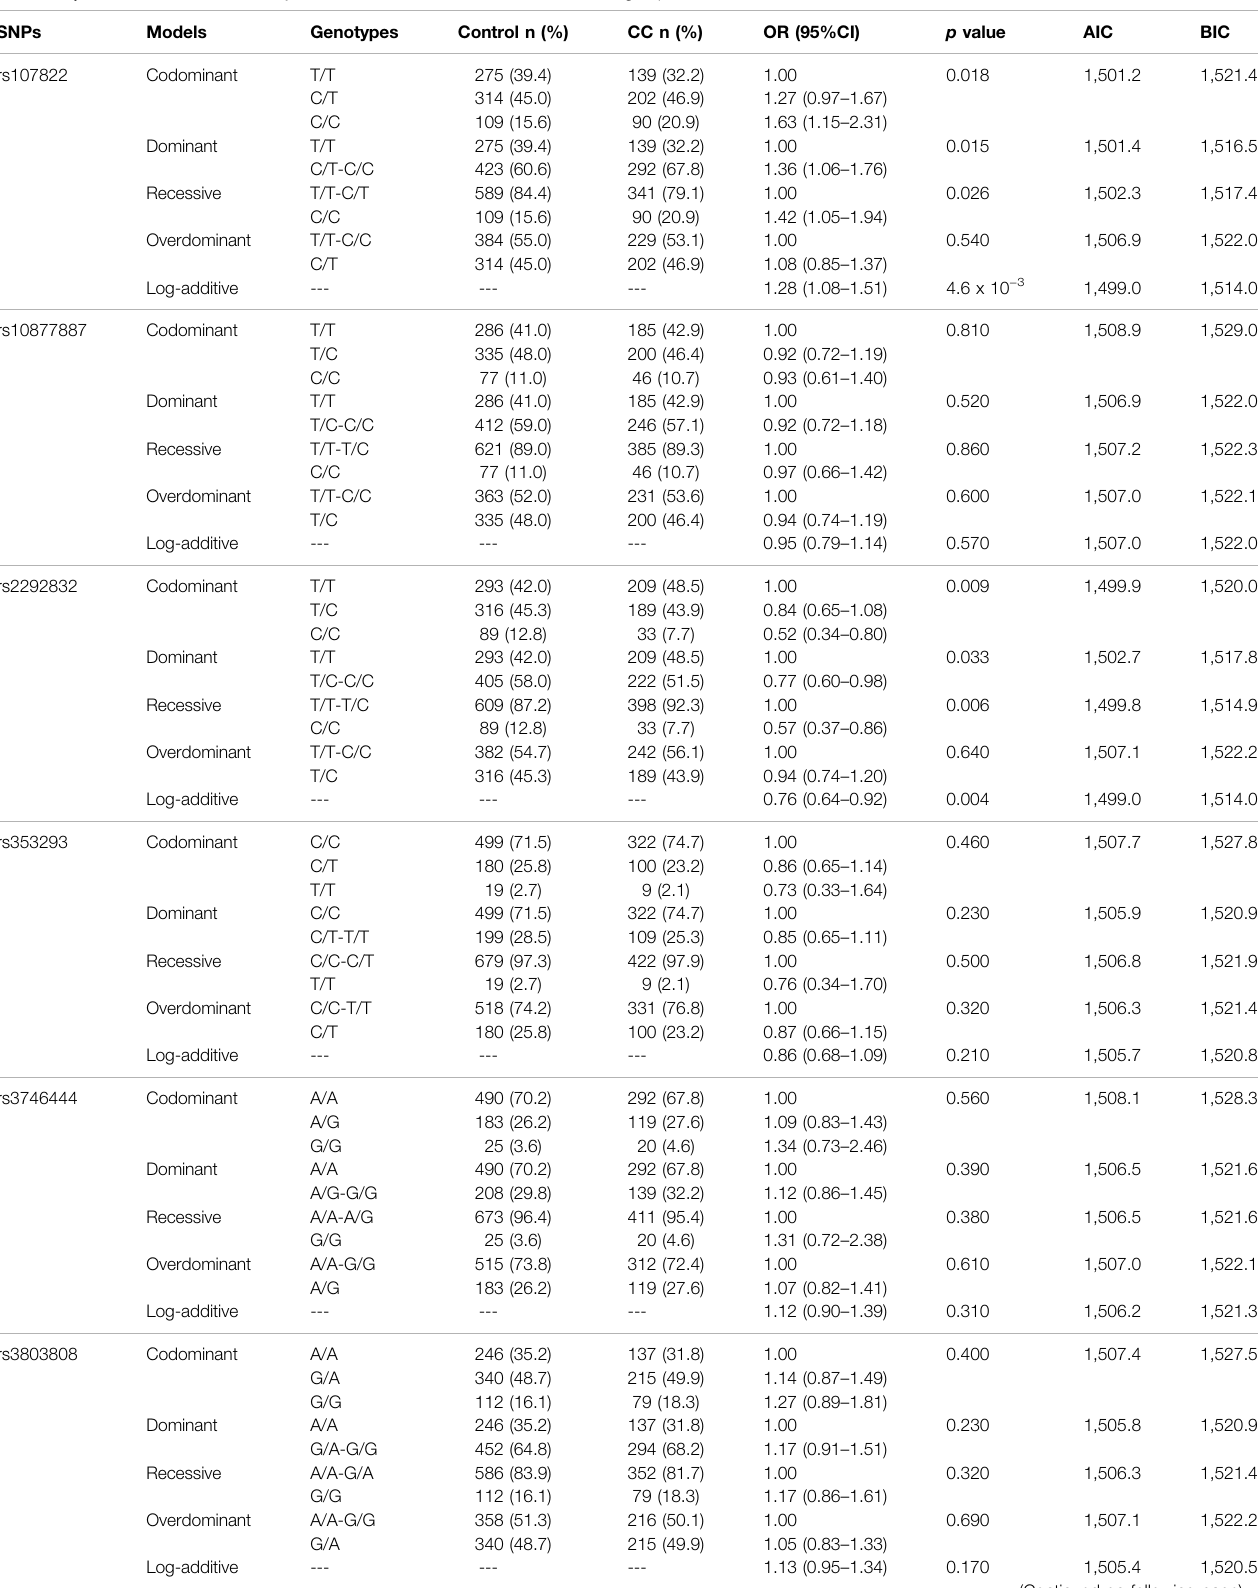
TABLE 6 | The inheritance model analysis of these SNPs between CC and control